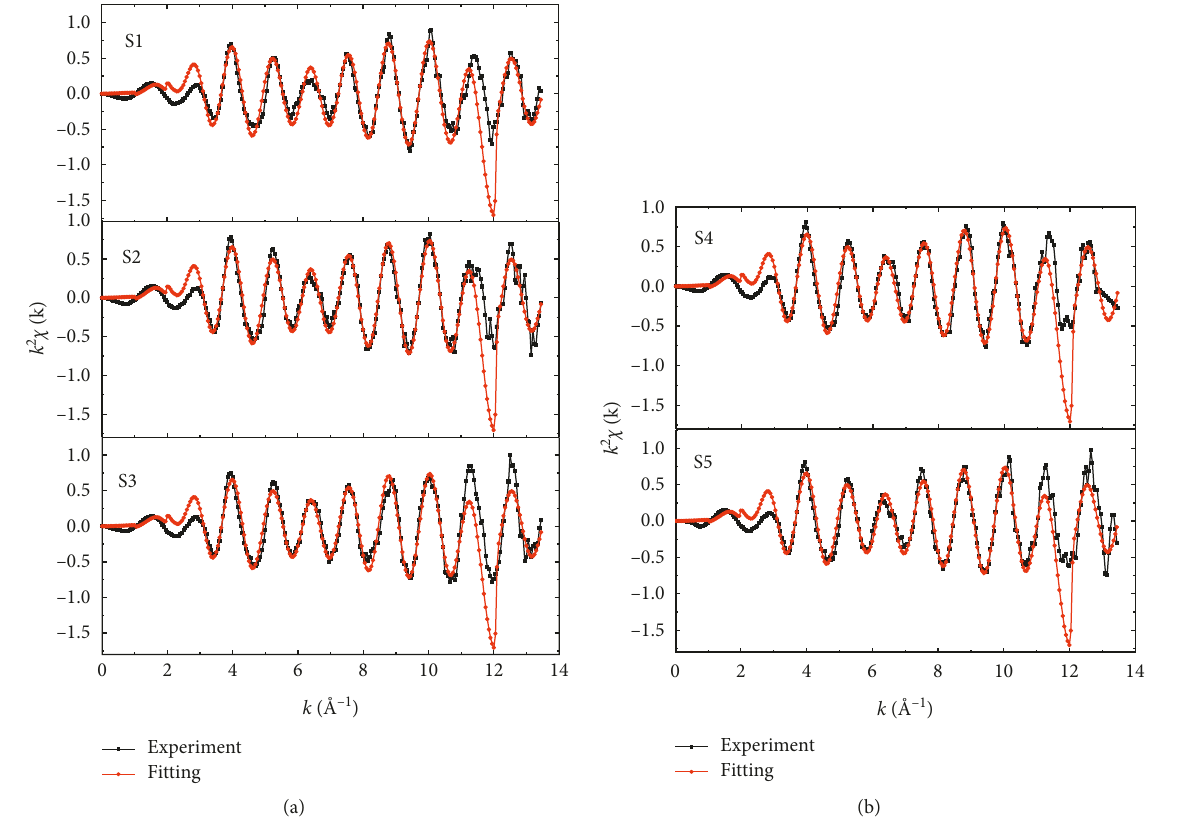
Figure 4: The In K-edge oscillation k 2 ( k ) for all the measured InSb thin film